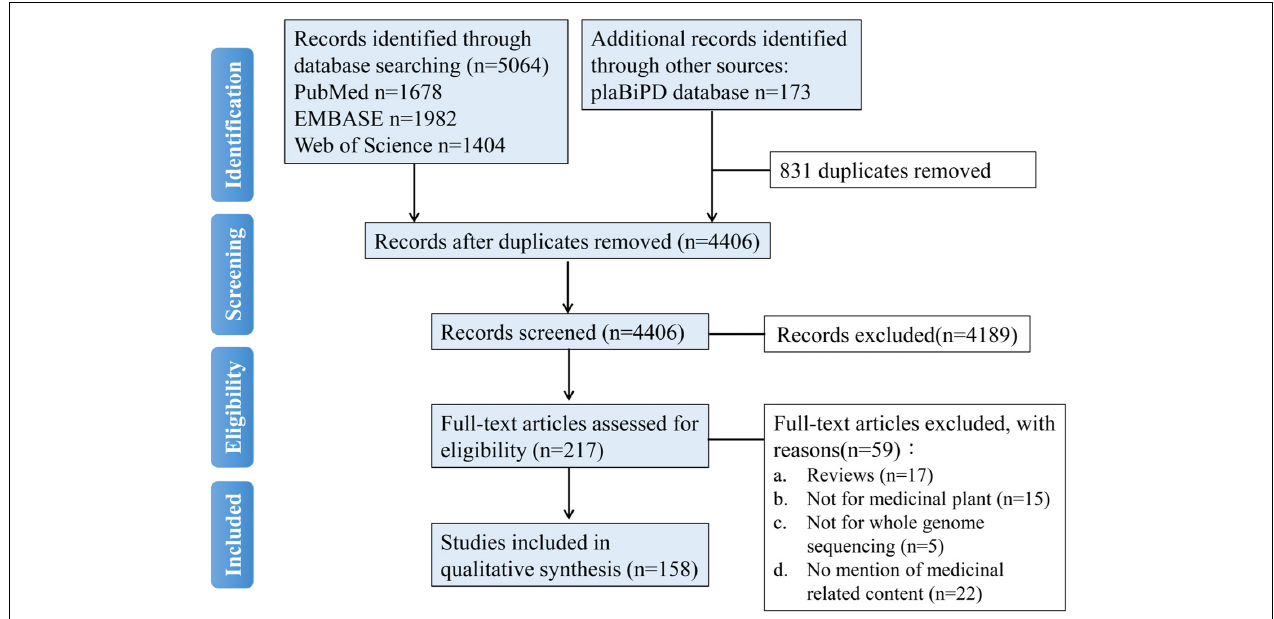
FIGURE 1 | A flowchart of literature search and selection for a systematic review about medicinal plant